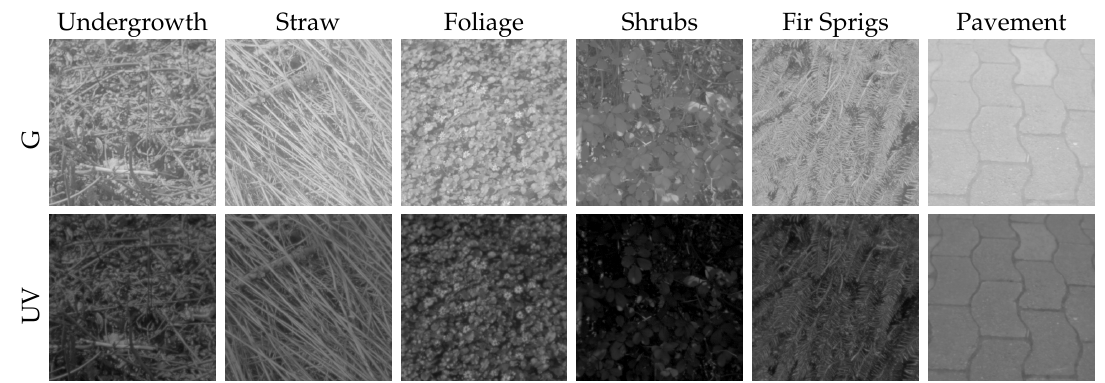
Figure 7. Examples of further collected data in the object database, which were not explicitly collected under specific lighting conditions as the data presented in Figure